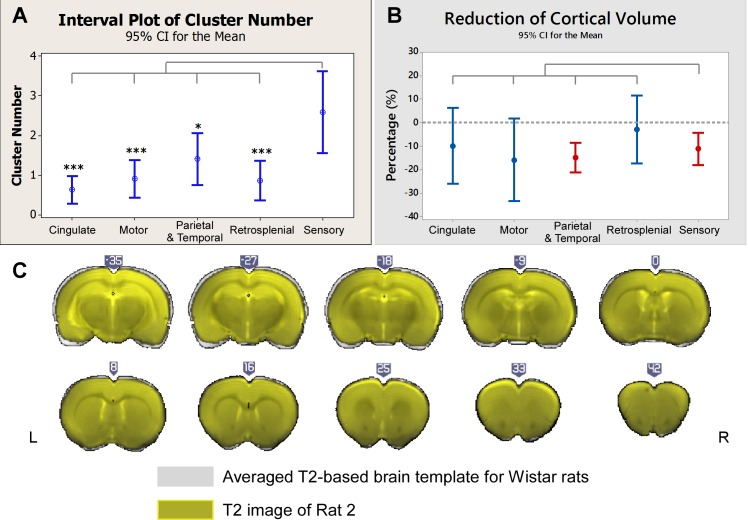
Distributions of irritative zones and morphological changes.(A) Comparisons of the numbers of IED-evoked BOLD response clusters for five cortical regions. The numbers of clusters in the sensory areas were significantly larger than those in other cortical areas. (B) Comparisons of the volume reduction in the same five brain regions as depicted in (A). The dash line indicates zero-change. The volume reductions in sensory and other cortices in the parietal and the temporal regions were significant (p < 0.05). No significant differences were found among cortical regions. (C) Coronal T2-weighted images of Rat 2 (in yellow) overlapped with the averaged brain templates (in grey) after registration (illustrated in MRIcroGL). Clear reduction in the cortical thickness was found in the anterior commissure. All compared to sensory cortex. *: p<0.05. **: p<0.01. ***: p<0.001. No asterisk means no significant difference. IED = interictal epileptiform discharge; BOLD = blood-oxygen-level dependent.